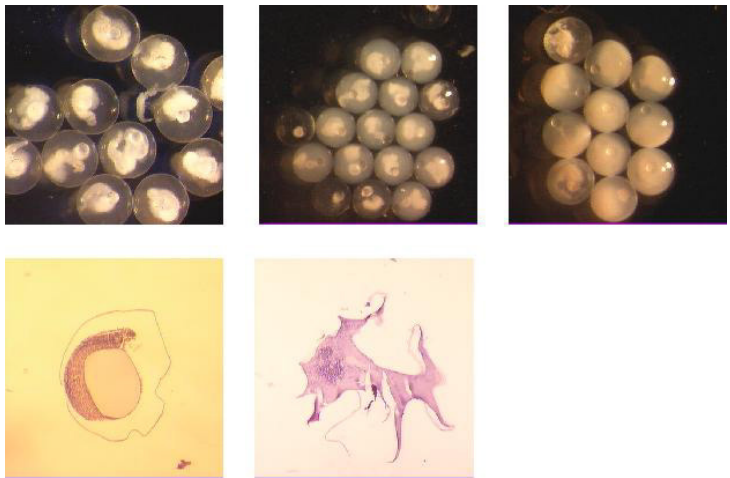
FIGURE 5. Seabream eggs after exposure to increasing LAS concentrations. (a,b,c) Eggs after exposure to 0.25, 0.50, and 5.00 mg l -1 LAS C 13 , respectively. (d,e) Histopathological view of seabream eggs after exposure to 5.00 and 10.0 mg l -1 LAS C 10 ,